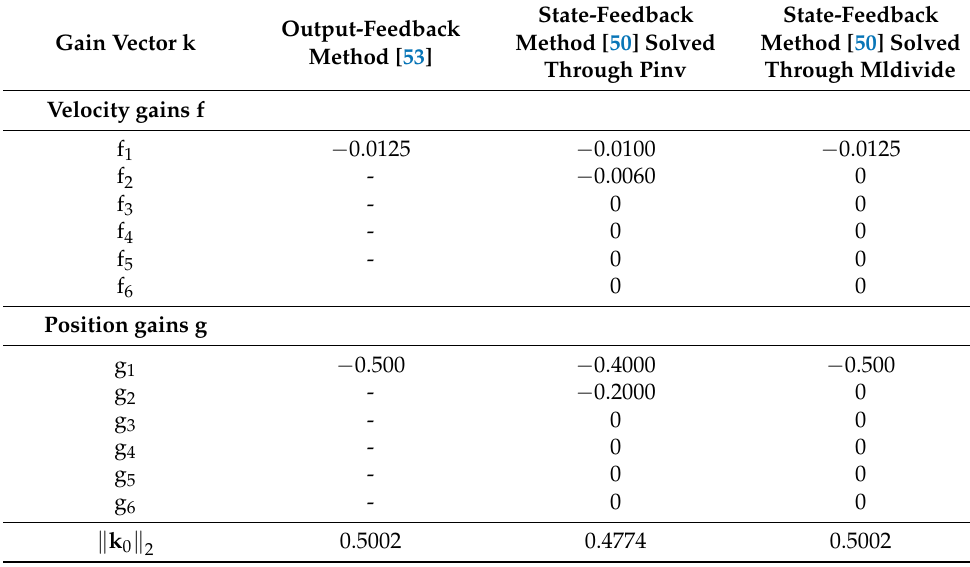
Table 5. The control gains in the numerical example of zeros assignment through unit-rank active control.